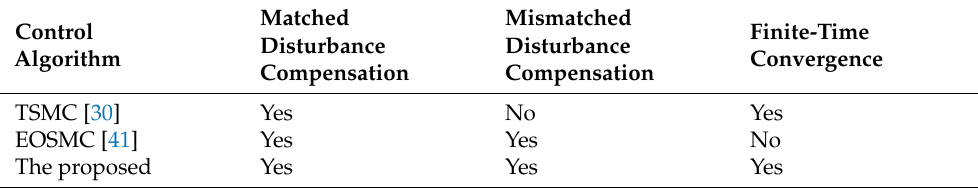
Table 1. Comparison of the proposed controller and other